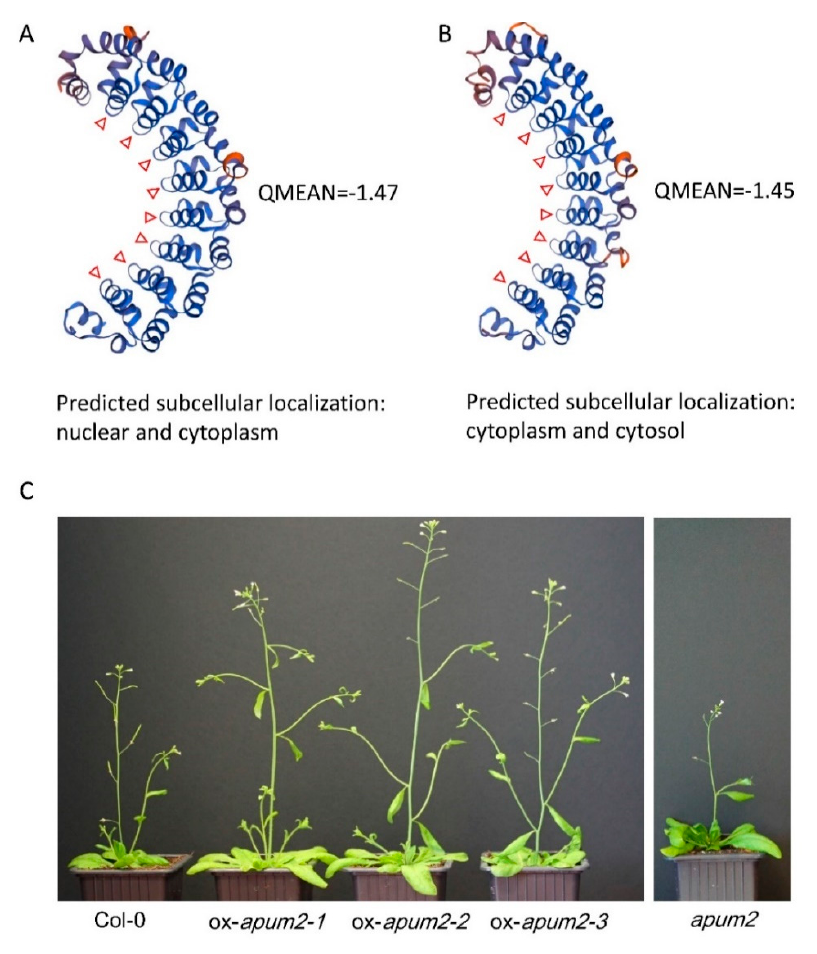
Figure 7. RhPUF4 could promote plant growth and bind to the PUF motifs. ( A , B ) Putative tertiary structures of RhPUF4 and APUM2, respectively, based on the prediction of the SWISS-MODEL database (https: // swissmodel.expasy.org / ); ( C ) phenotypes of ox-APUM overexpression transgenic Arabidopsis plants and of the knockout mutant apum2 as compared to the wild type. The APUM2 and RhPUF4 protein sequences were downloaded from the TAIR (https: // www.arabidopsis.org / ) and GDR (https: // www.rosaceae.org / ) databases. The red triangles represent pumilio repeats.